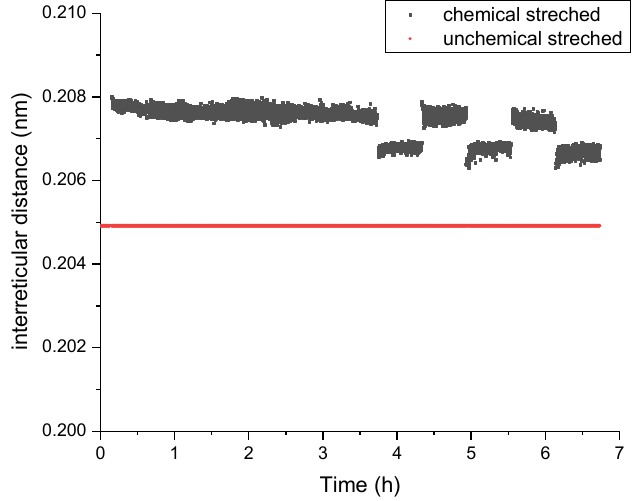
Figure 21. Distance between crystallographic planes (111) for the metal peak.